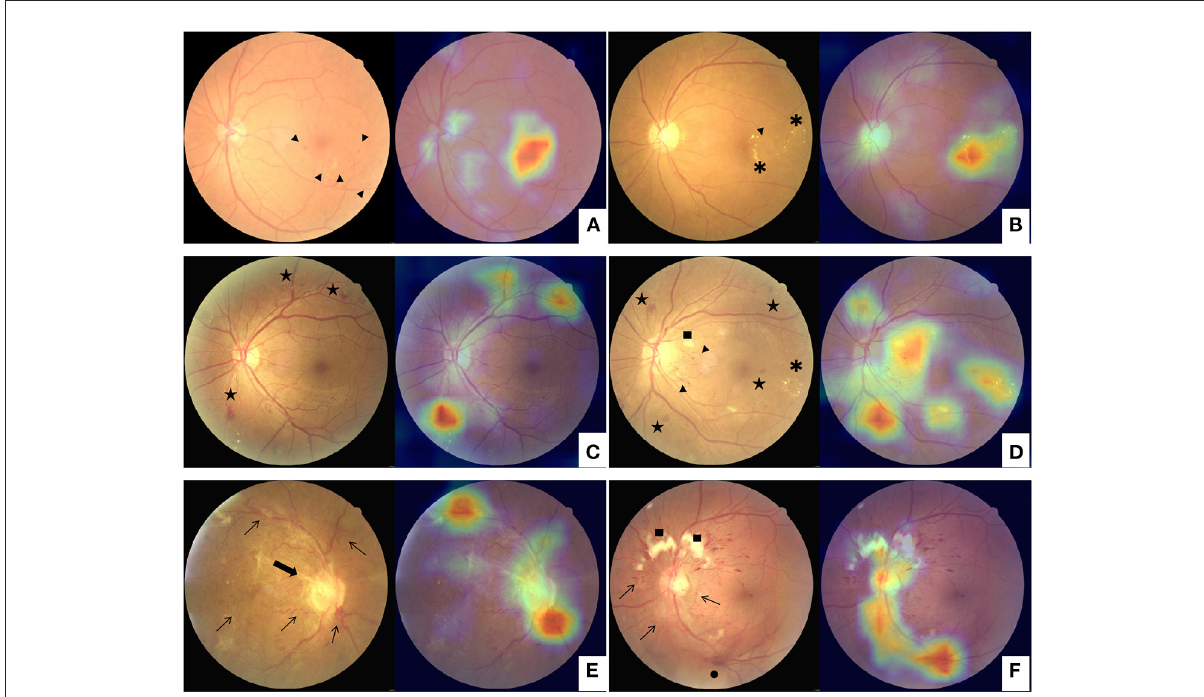
FIGURE1 Examples of class activation mapping of lesion on the fundus images with mild diabetic retinopathy (A,B) , moderate and severe diabetic retinopathy (C,D) , and proliferative diabetic retinopathy (E,F) by automated grading system. The augmented image includes the original fundus images (Left) and one highlighted image that indicates the location of the lesions (Right). Arrowhead: microangiomas; Asterisk: hard exudates; Pentagram: intraretinal hemorrhages; Square: cotton-wool spot; Arrowhead: tail; Thin arrows: neovascularization; Thick arrow: fibrovascular proliferation; Black dot: vitreous